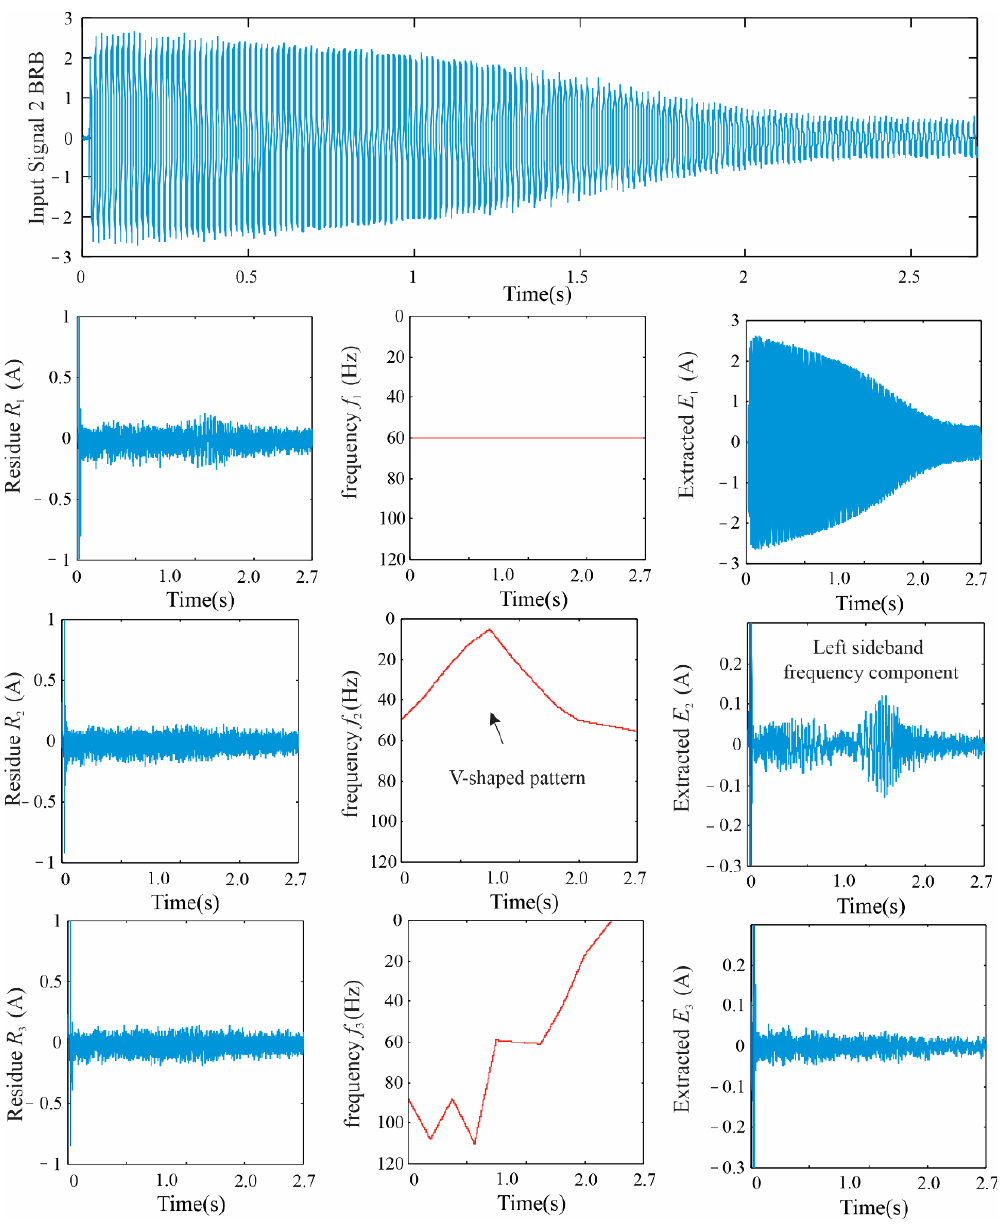
Figure 13. FBASD output for the 2BRB case.